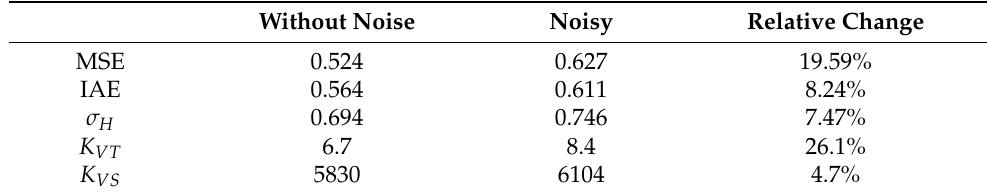
Table 14. G 3 ( s ) CPA indexes.